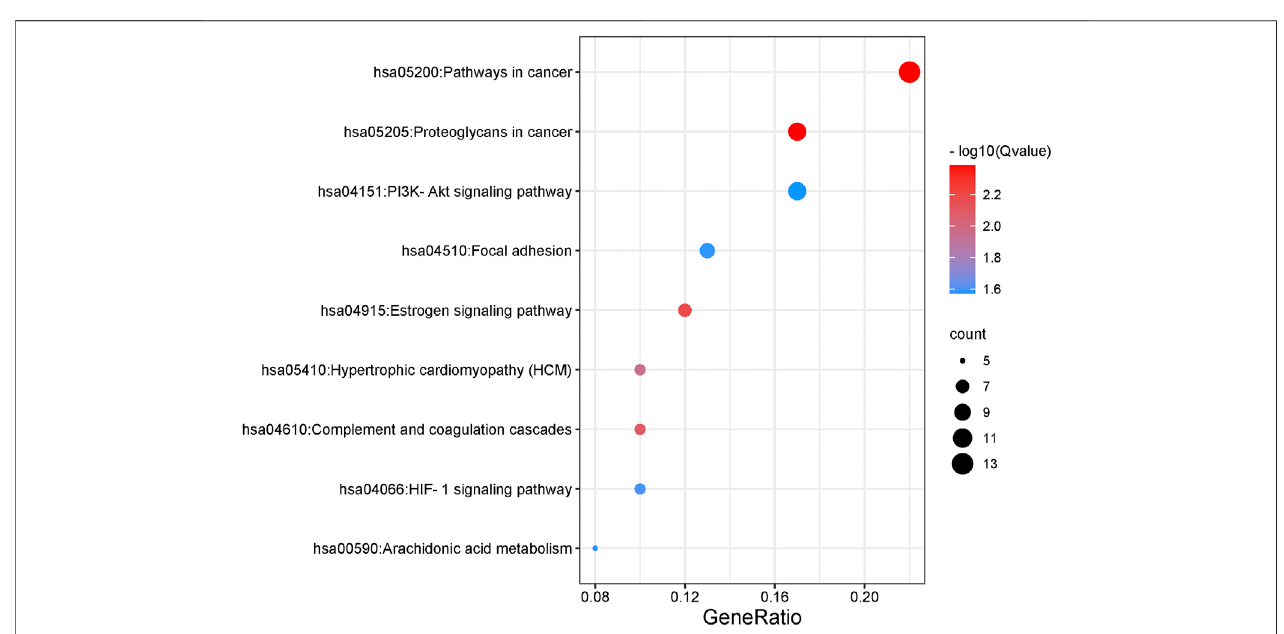
FIGURE 4 | Results of top nine KEGG pathway